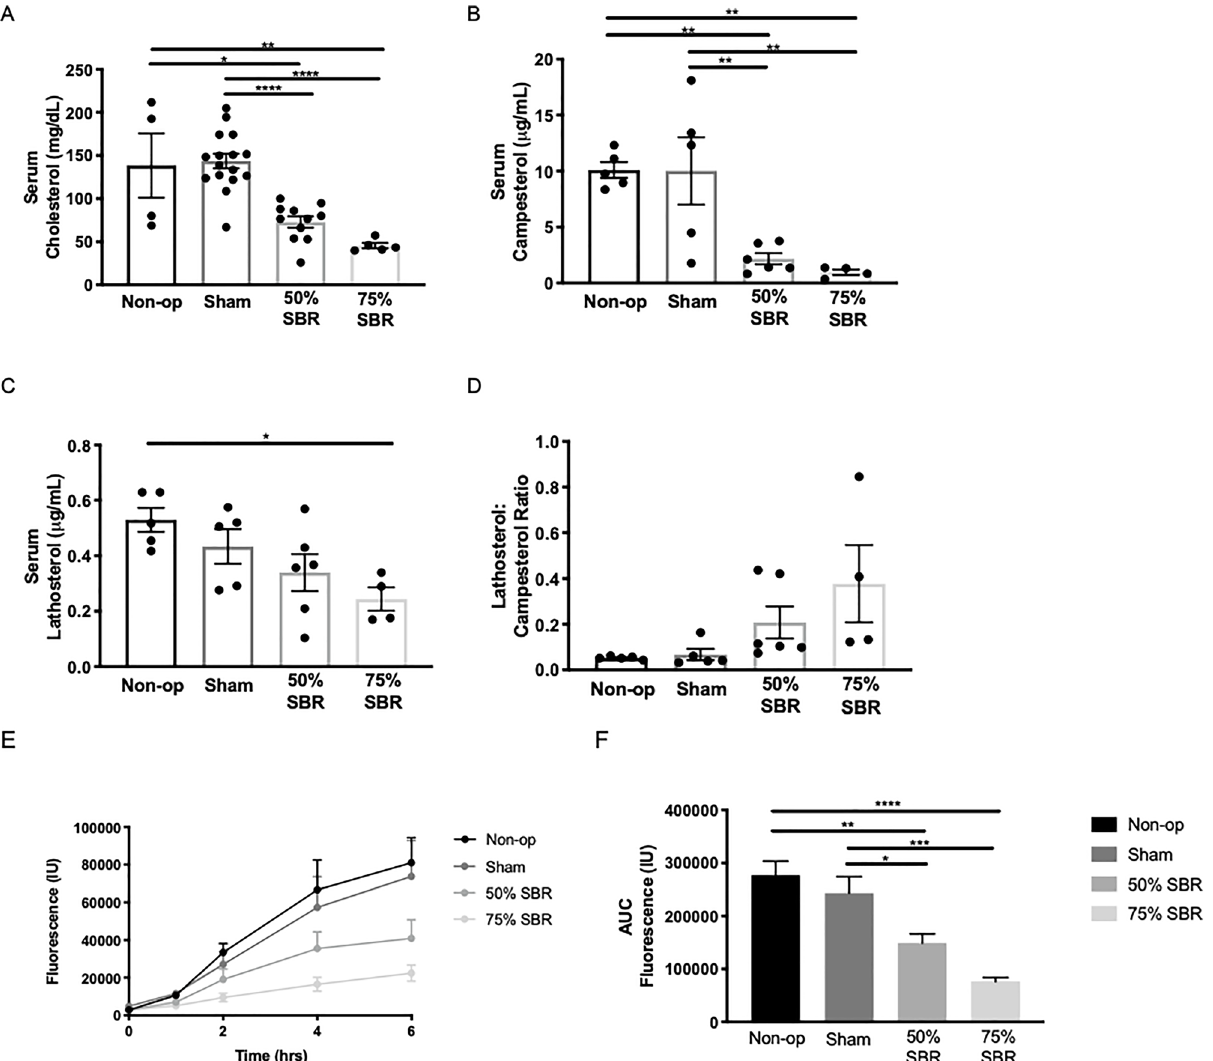
Figure 2. Effects of SBR on cholesterol and its derivatives. ( A ) Serum cholesterol levels in non-op ( n = 4), sham ( n = 16), 50% SBR ( n = 11), and 75% SBR ( n = 5) mice. ( B ) Serum campesterol levels, ( C ) lathosterol levels, and ( D ) lathosterol:campesterol ratios in non-op ( n = 5), sham ( n = 5), 50% SBR ( n = 6), 75% SBR ( n = 4) mice. Exogenous absorption of TopFluor-cholesterol assessed via fluorescence over ( E ) time course and as ( F ) area under the curve in non-op ( n = 5), sham ( n = 6), 50% SBR ( n = 6), and 75% SBR ( n = 5) mice. * p < 0.05, ** p < 0.005, *** p < 0.001, **** p <